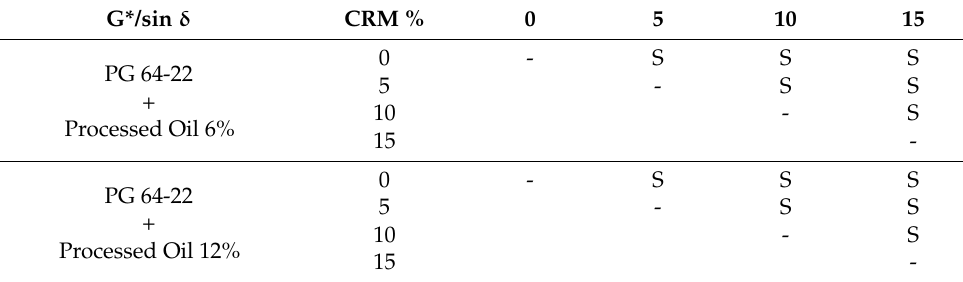
Table 6. Statistical analysis results of G*/sin δ for PG 64-22, with processed oil as a function of CRM content ( α = 0.05).